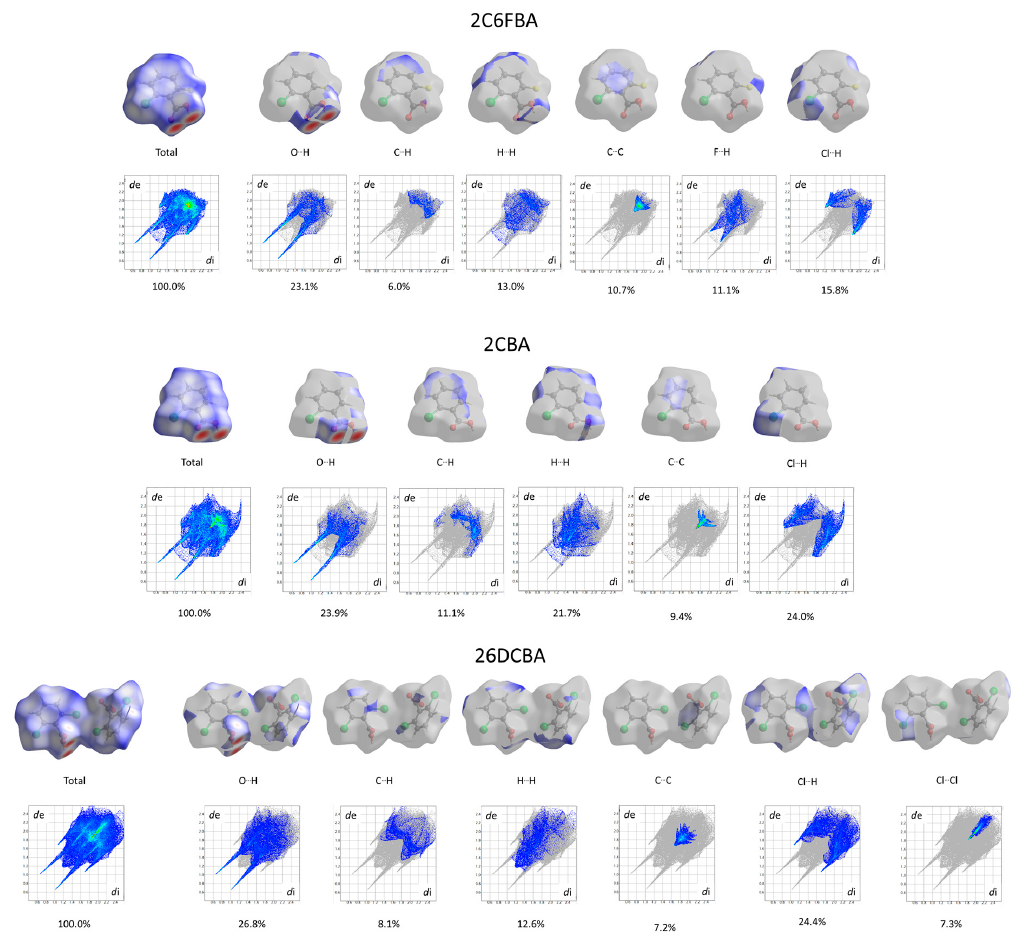
Figure 22. Total and atom … atom d norm Hirshfeld plots and 2D-fingerprint plots ( d e , d i ) for 2C6FBA, 2CBA and 26DCBA. Grey, colors means no interaction, blue-to-red colors mean increasing strength of interaction (in the d norm Hirshfeld plots) or increased number of interactions (in the 2D fingerprint plots). Table 9. Atom … atom interactions (%) in the crystals of the studied compounds, according to the Hirshfeld method ( d norm signatures).